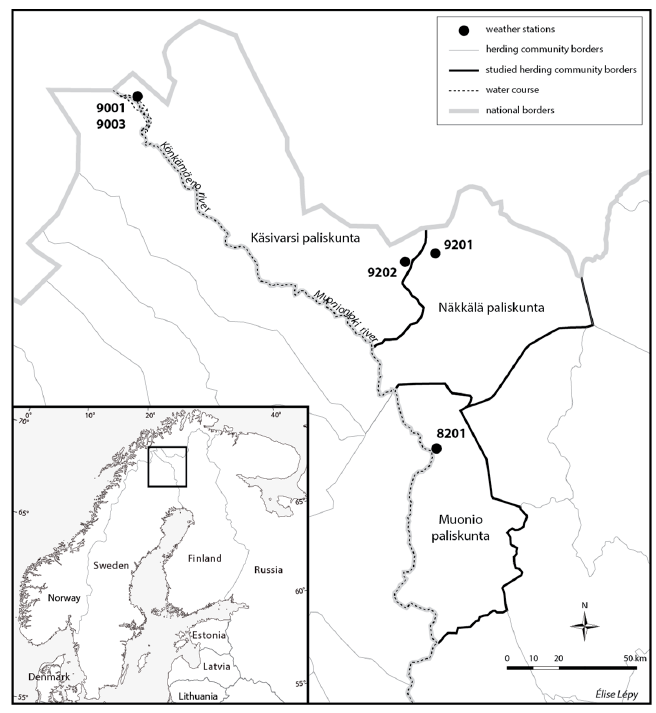
Figure 1. Location map.